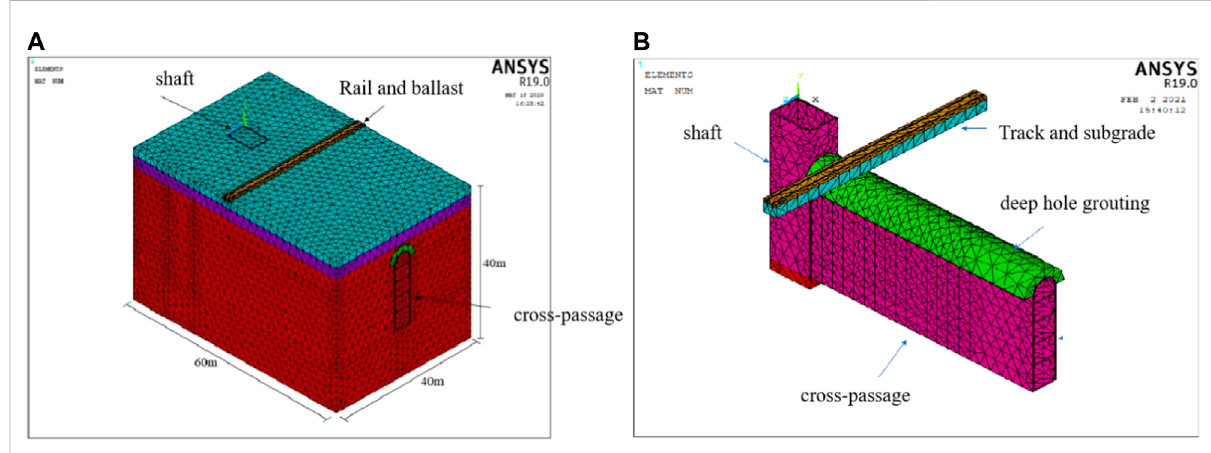
FIGURE 10 Calculationmodelofshaftandcrosspassage. (A) isamodelforwholegroundsoil; (B)